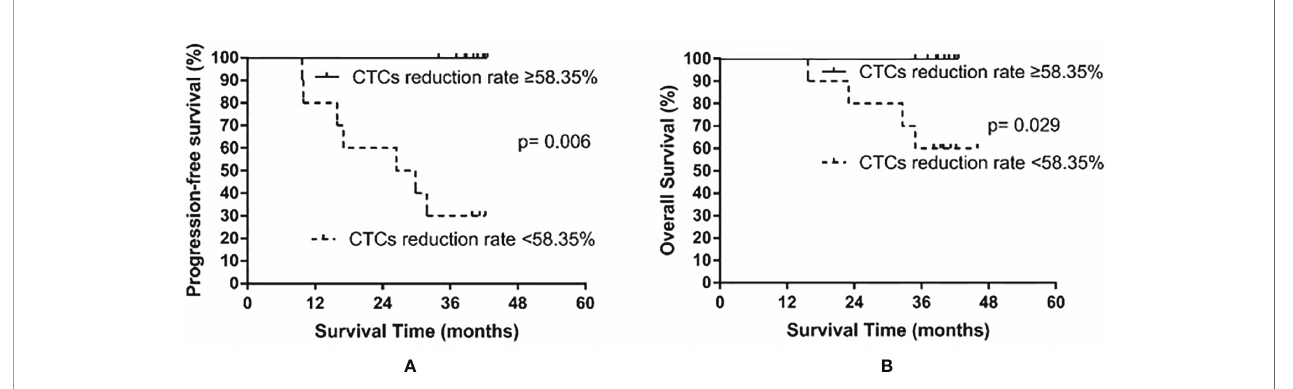
FIGURE 5 | Progression-free survival (A) and overall survival (B) in small cell lung cancer patients according to the rate of circulating tumor cell (CTC) decline after prophylactic cranial irradiation.